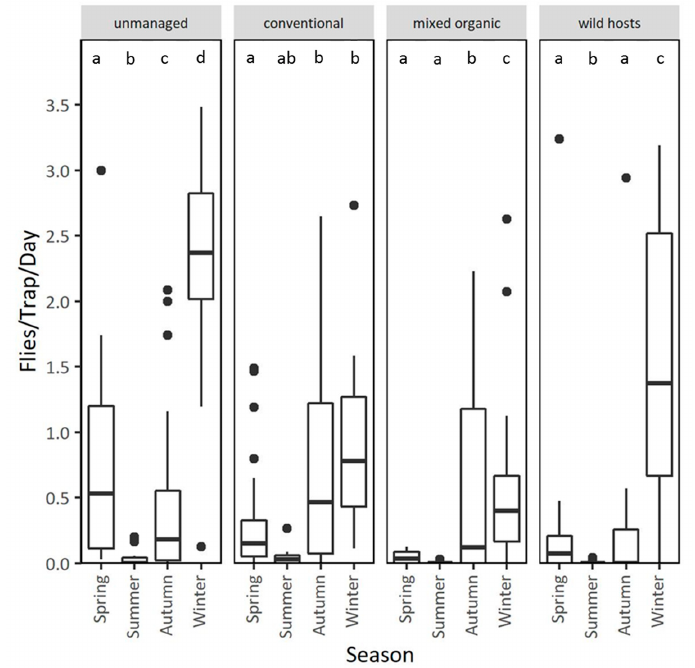
Figure 5. Adult captures in unmanaged and conventionally treated cherry trees, stone fruit trees of a mixed organic orchard and wild hosts – Rubus sp., of the coastal area Lehonia, grouped by season. Values within a chart followed by the same letter do not differ significantly ( p > 0.05).